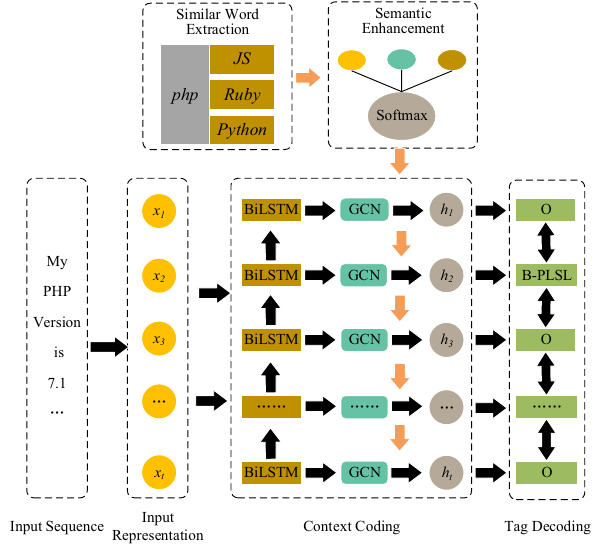
Fig. 1 Architecture of the proposed AttenSy-SNER